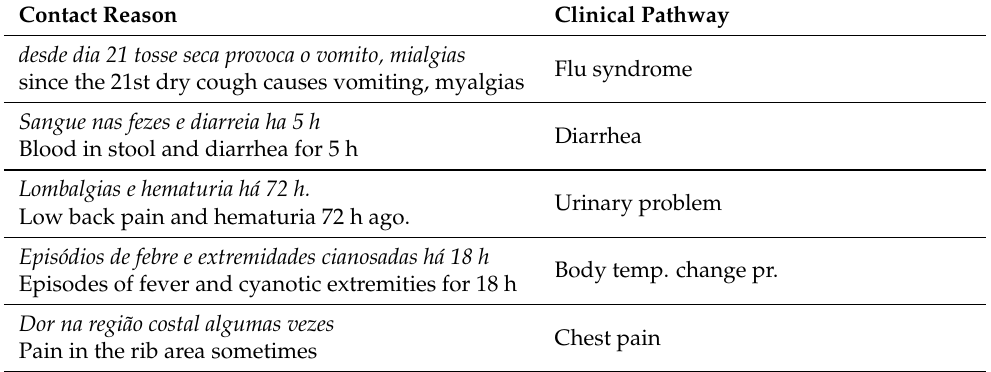
Table 1. Cont. Contact Reason Clinical Pathway since the 21st dry cough causes vomiting,